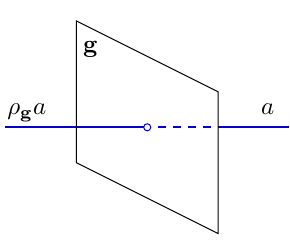
Figure 2 . When a symmetry operator of type a 2 A crosses a codimension-1 symmetry operator of type g 2 G , it emerges transformed by an automorphism (cid:26) g of A